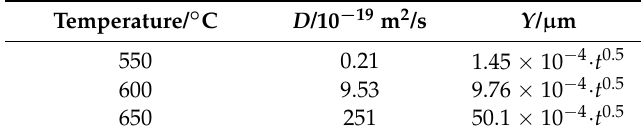
Table 1. Fitting results of the growth rate and the relationship between diffusion layer thickness and aging time (s).